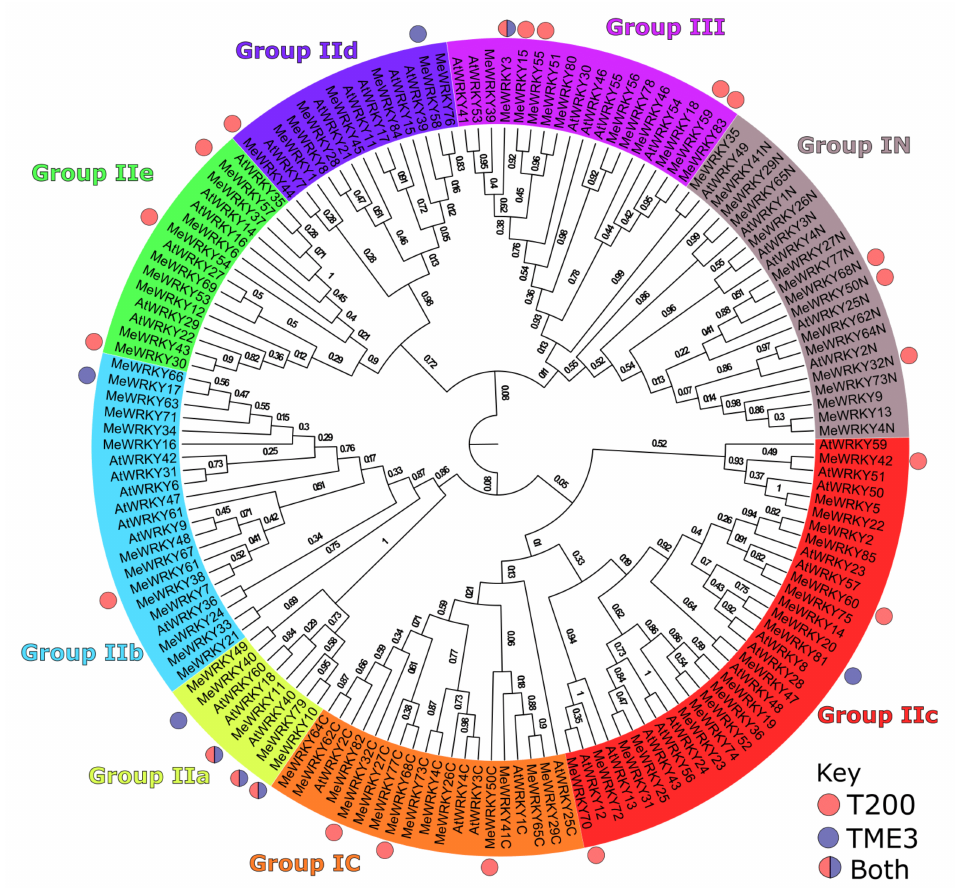
Figure 5. Phylogenetic tree of WRKY transcription factors from Arabidopsis thaliana (At) and cassava [ Manihot esculenta (Me)] sorted into taxonomic groups based on amino acid sequences (bootstrap value of a 1000). Group I is characterized by two WRKY domains and two C2H2 zinc finger domains; Group II by one WRKY domain and a C2H2 zinc finger motif; and Group 3 has one WRKY domain and a C2HC zinc finger motif. Group 1 has been subdivided into two sub-groups (Group IC and Group IN) representing the alignment of the C and N termini of the protein, respectively. The tree (adapted from Wei et al., 2016) is annotated (dots) with the MeWRKYs identified as differentially expressed following SACMV